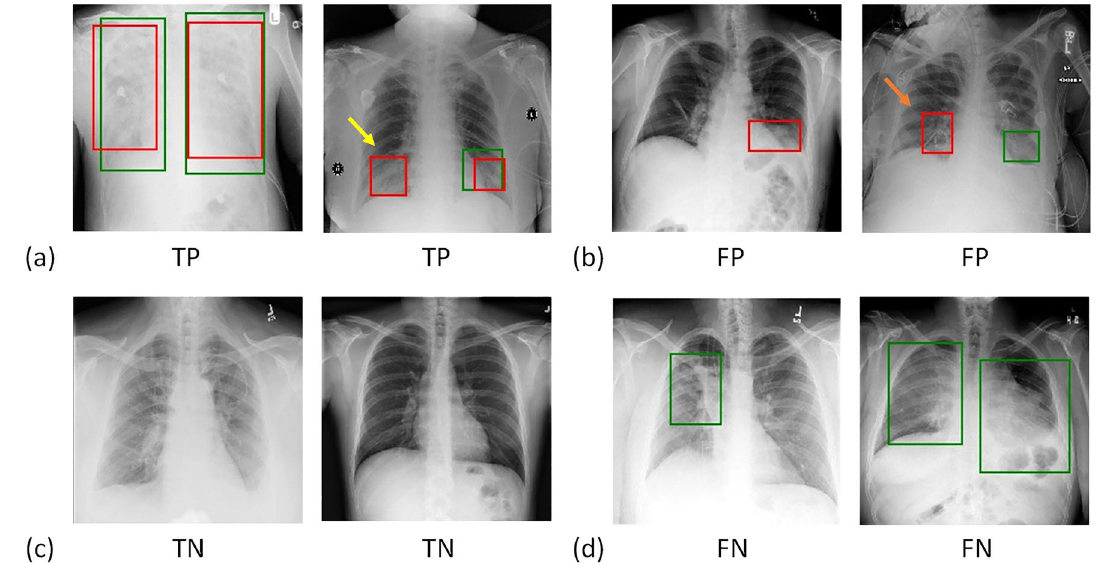
Figure 4. Example results of predicted cases, including ( a ) true positives (TP), ( b ) false positives (FP), ( c ) true negatives (TN), and ( d ) false negatives (FN). The true and predicted lung-opacity regions are denoted by green and red bounding boxes, respectively. Within the definitions of this study, we considered the second example in ( a ) to be a TP despite one of the two predicted boxes (yellow arrow) not overlapping with the reference box. We regarded the second example in ( b ) as an FP. Although the CXR model correctly predicted this as positive, the predicted region, indicated by the orange arrow, does not overlap with the green box.